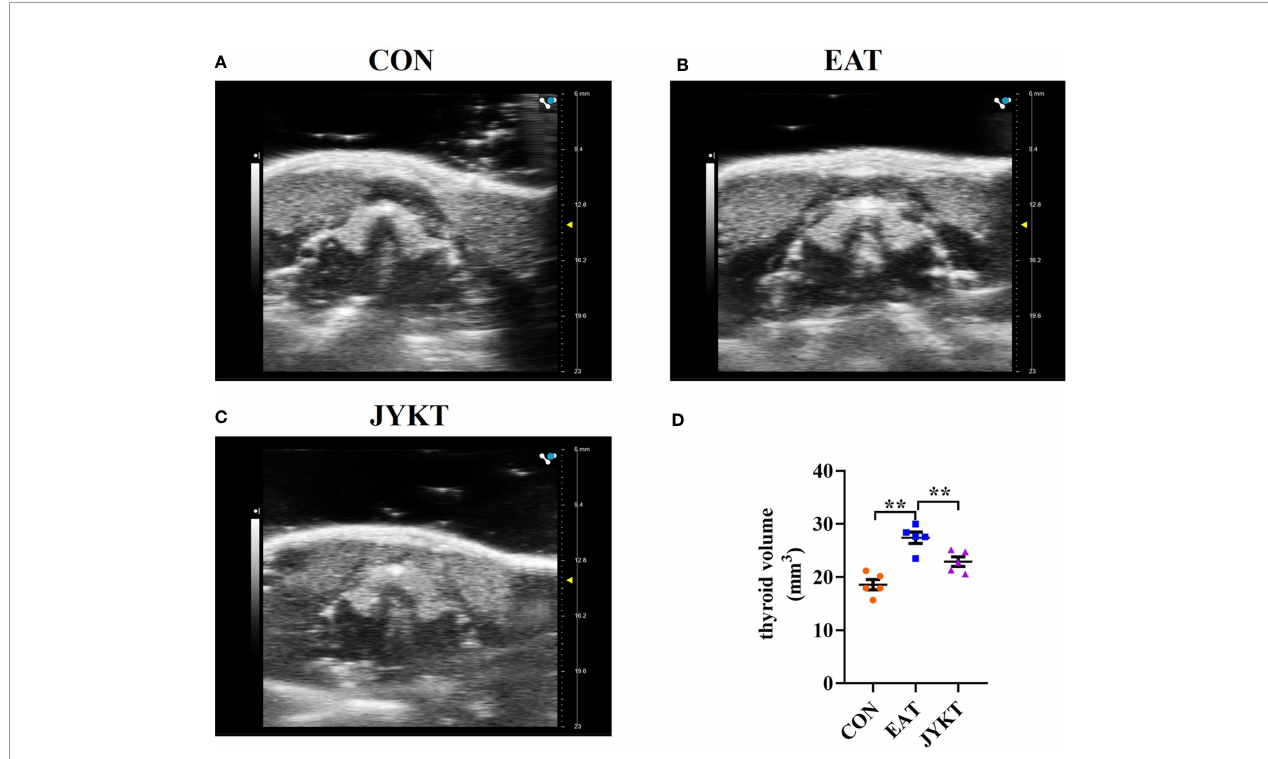
FIGURE 3 | Morphology of thyroid in the CON (A) , EAT (B) and JYKT group (C) by ultrasonography. (D) Thyroid volumes among groups. ** P < 0.